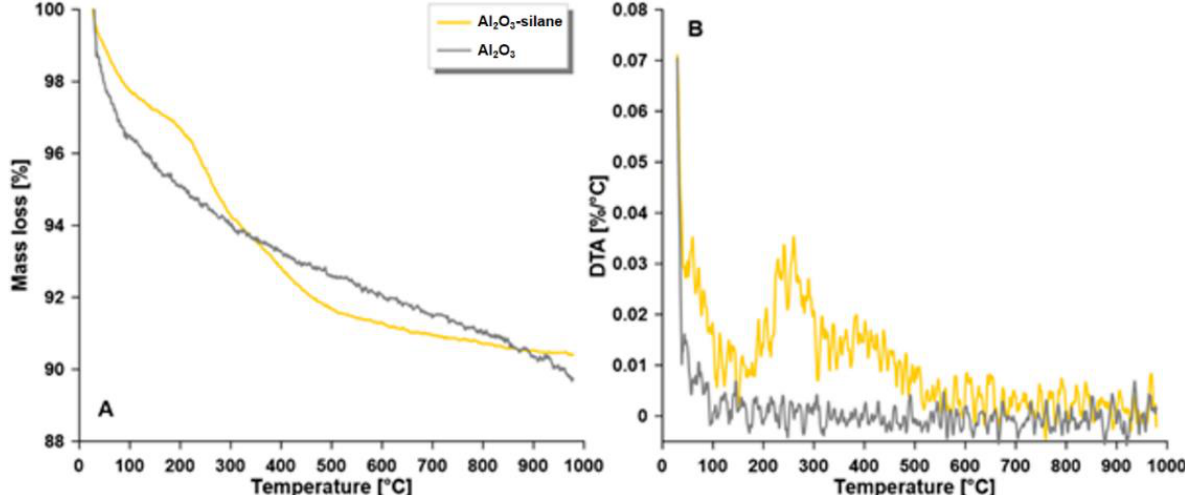
Figure 1. ATR – FTIR spectra of pristine Al 2 O 3 and Al 2 O 3 modified with silanes: ( A ) range of 4000 – 2500 cm −1 , ( B ) range of 1800 – 1000 cm −1 .